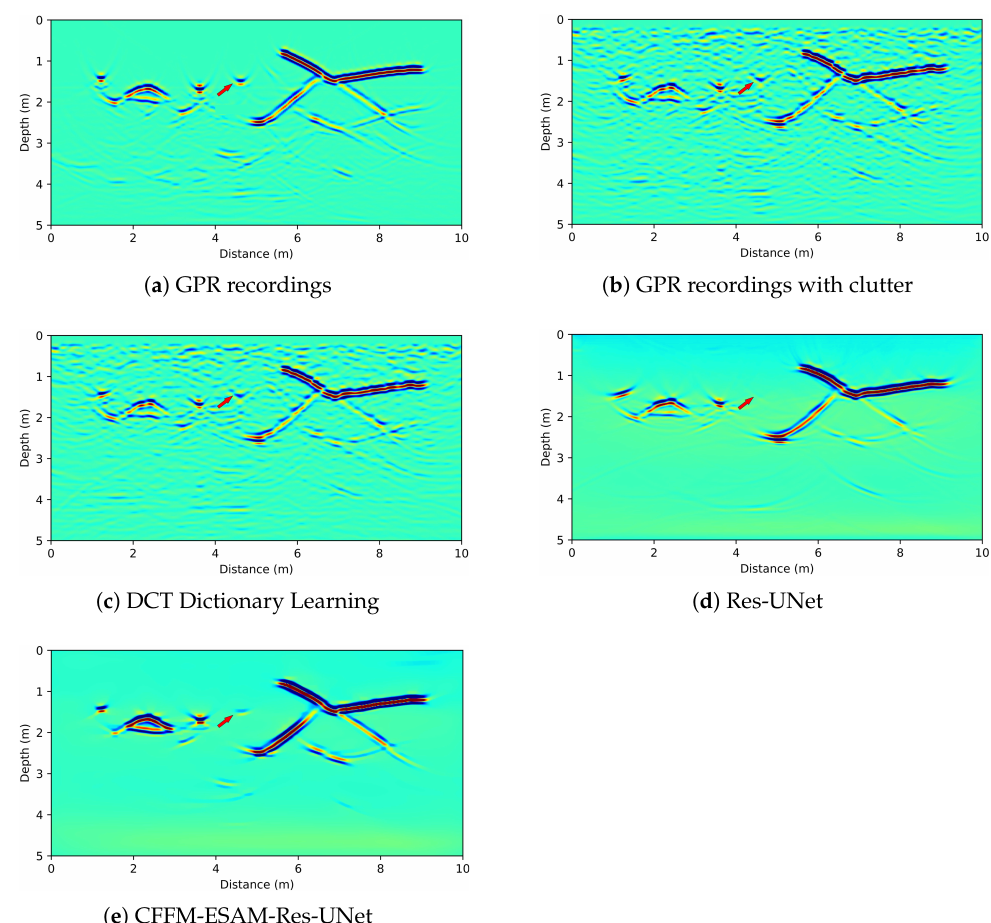
Figure 11. RTM imaging results of synthetic GPR recordings after different processing methods.